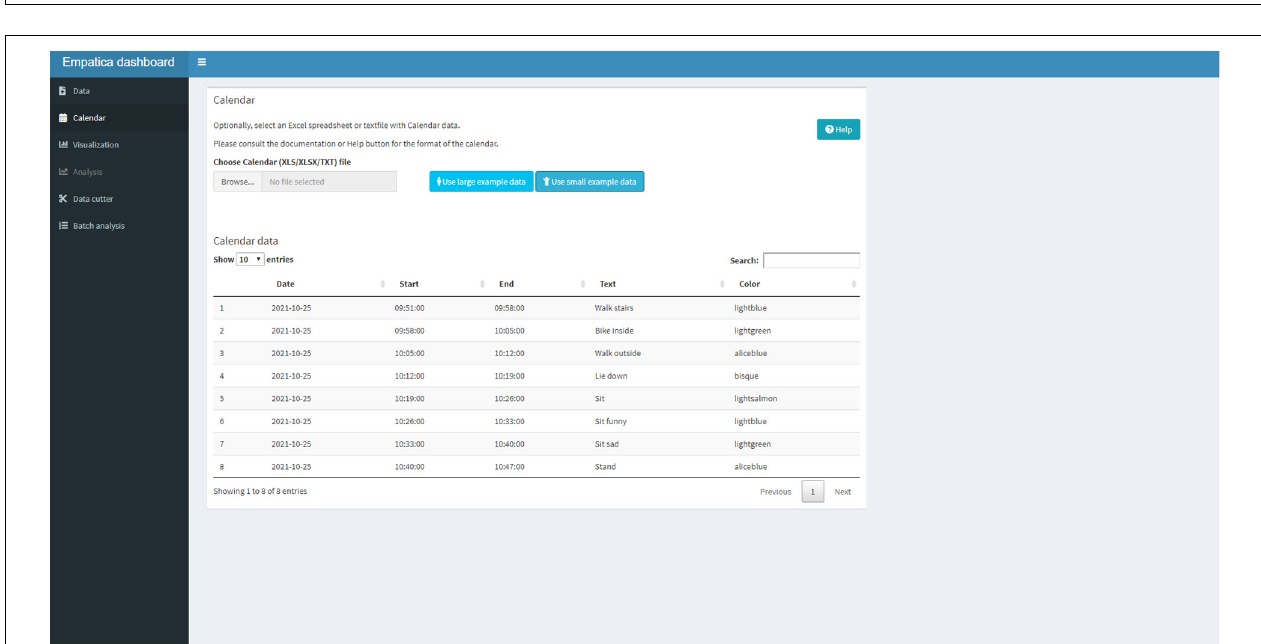
FIGURE 4 | The calendar tab that can be used to add text to the visualization and color shade activities.